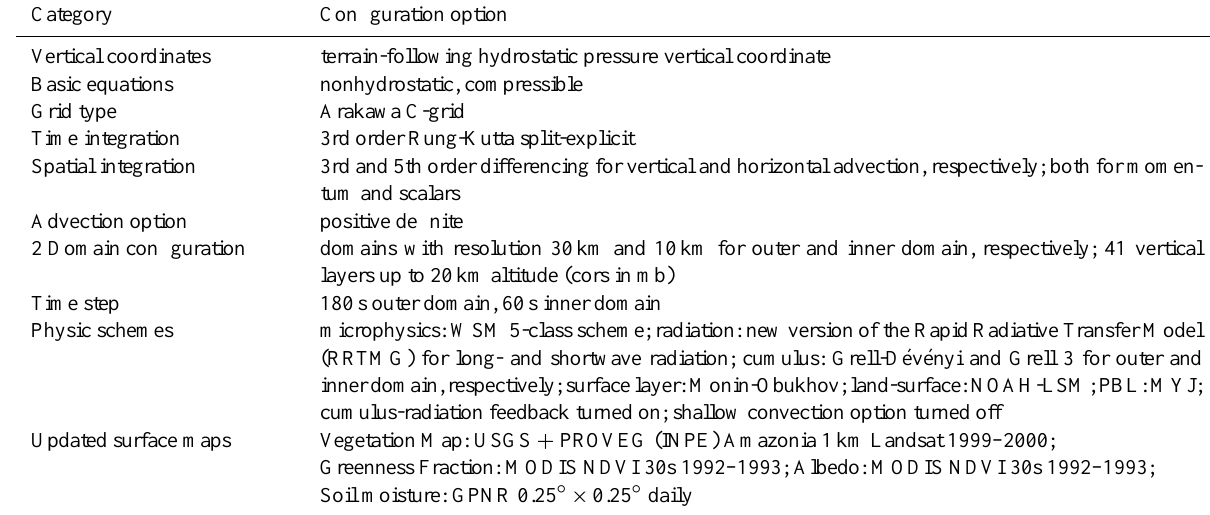
Table 1. Overview over WRF configurations, physics options, and updated surface maps used for the WRF-GHG simulations in the Amazon